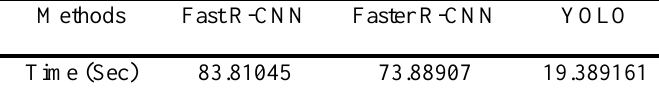
Table 7. Comparative analysis based on